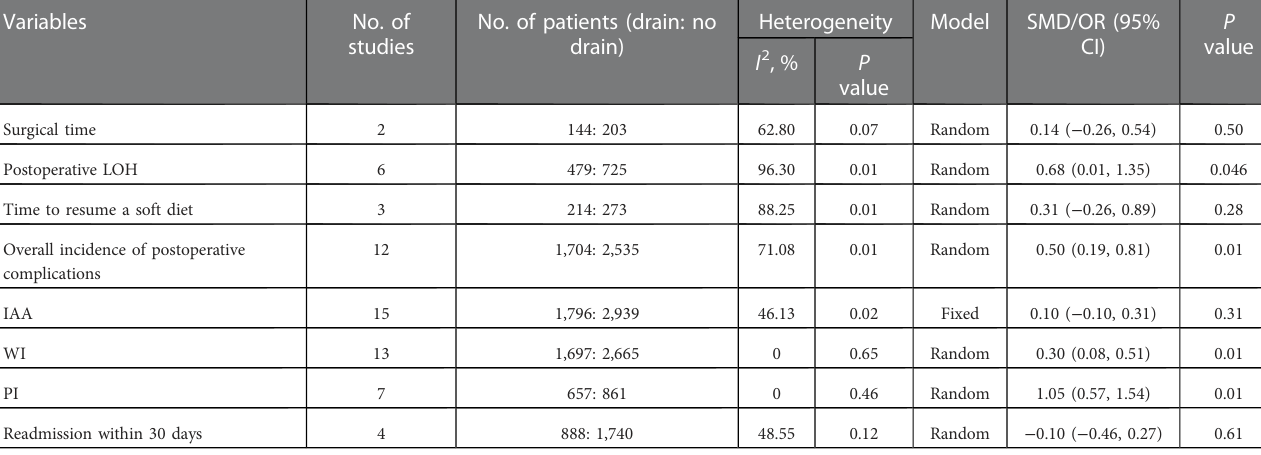
TABLE 3 Meta-analysis of surgical feature, postoperative complications, and postoperative recovery. Variables